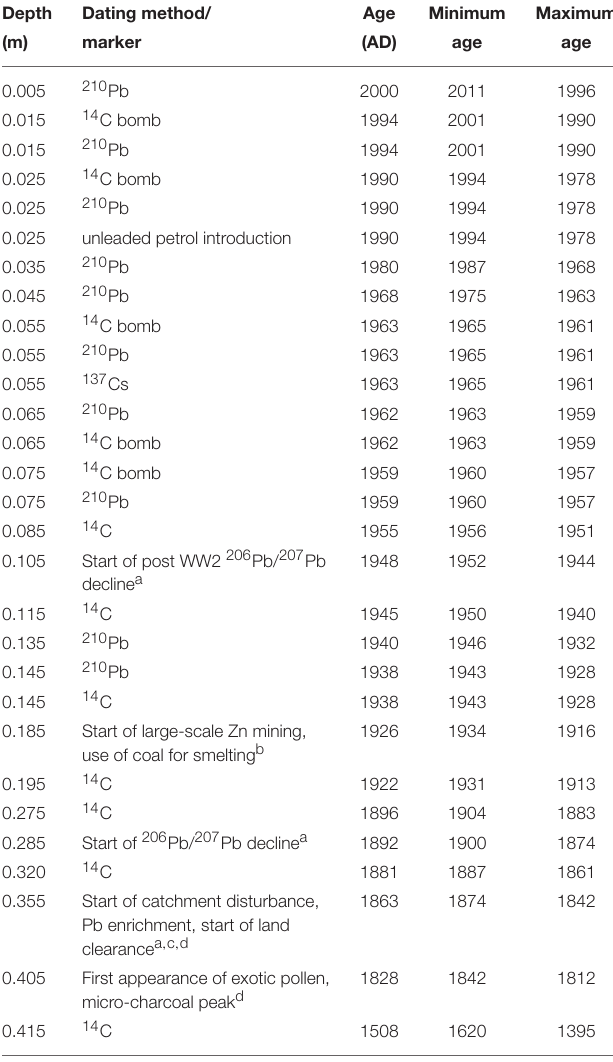
TABLE 1 | Chronology of the pollen record (after Gehrels et al., 2012).